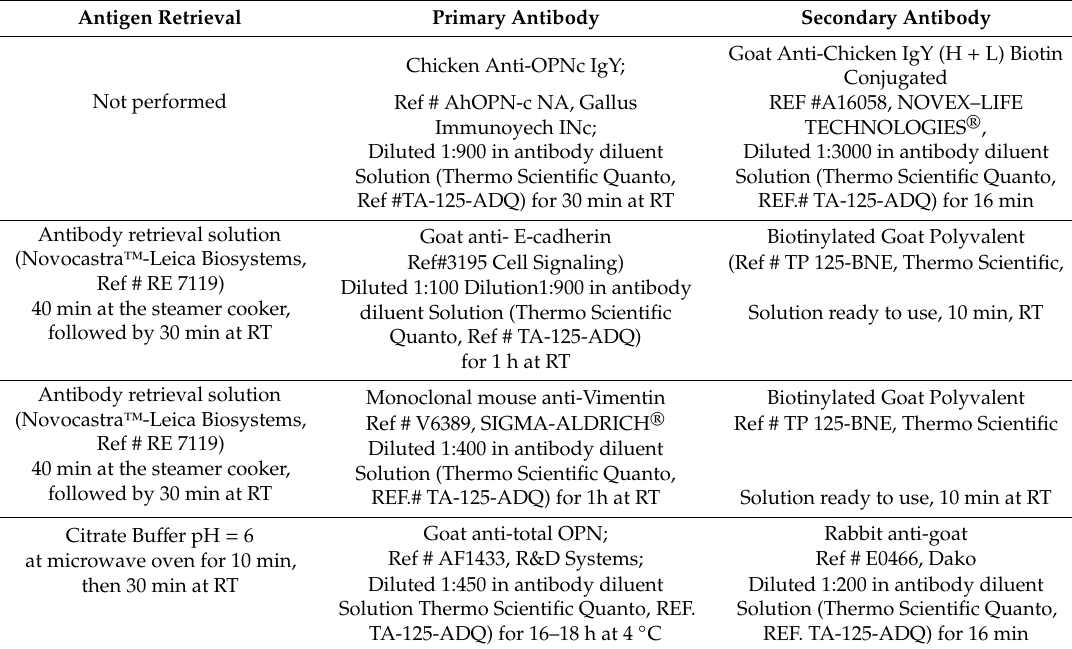
Table 1. Antigen retrieval and antibody experimental used conditions at